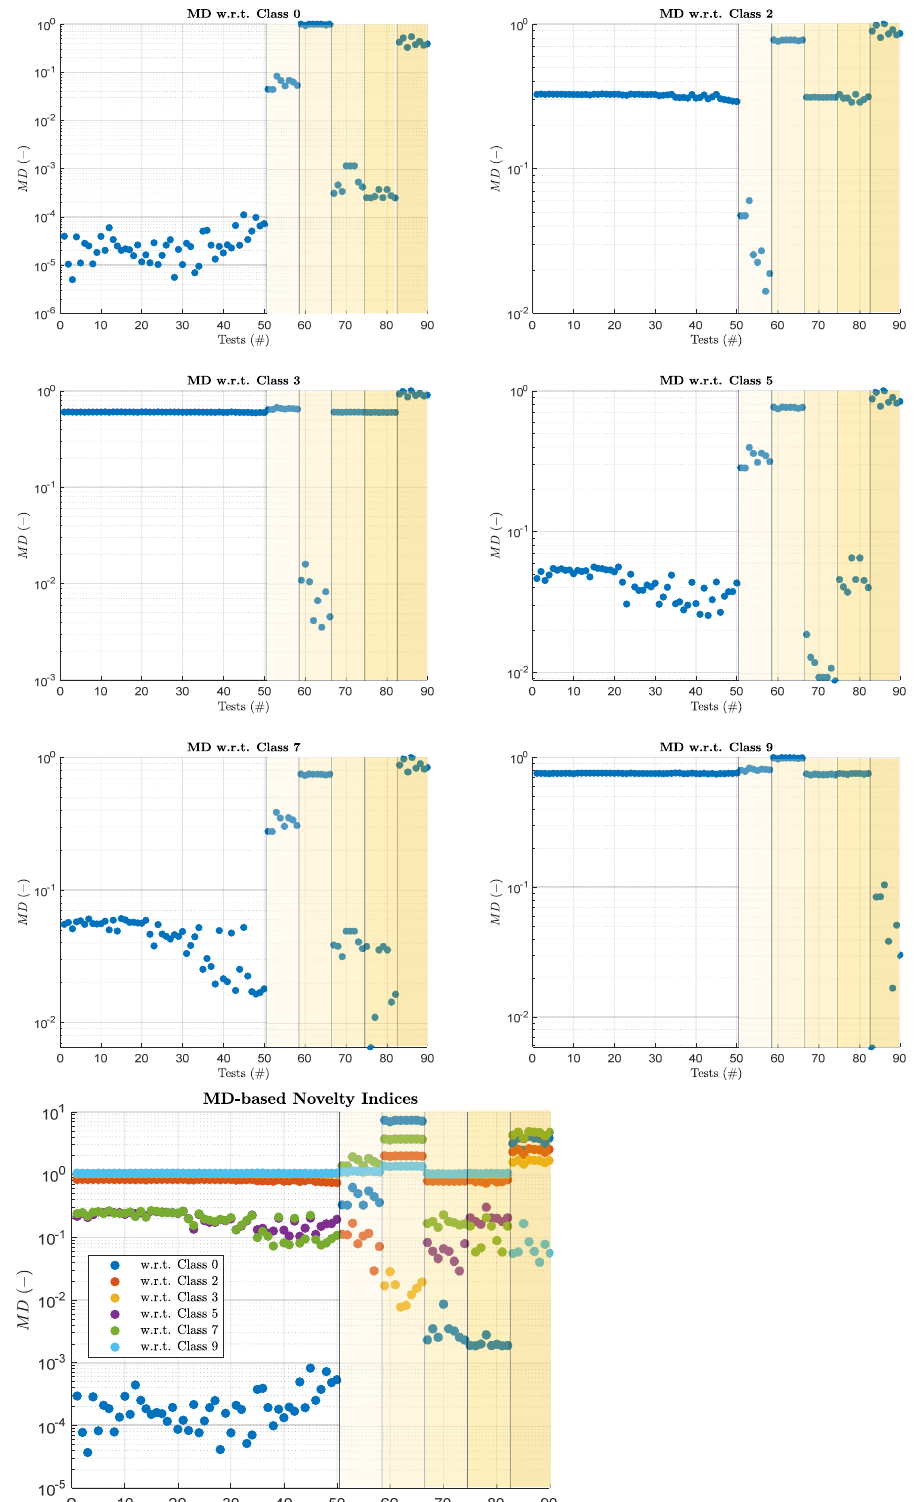
Figure 9. Representation of the first 3 Mahalanobis distances (i.e., calculated with respect to groups 0, 2 and 3).